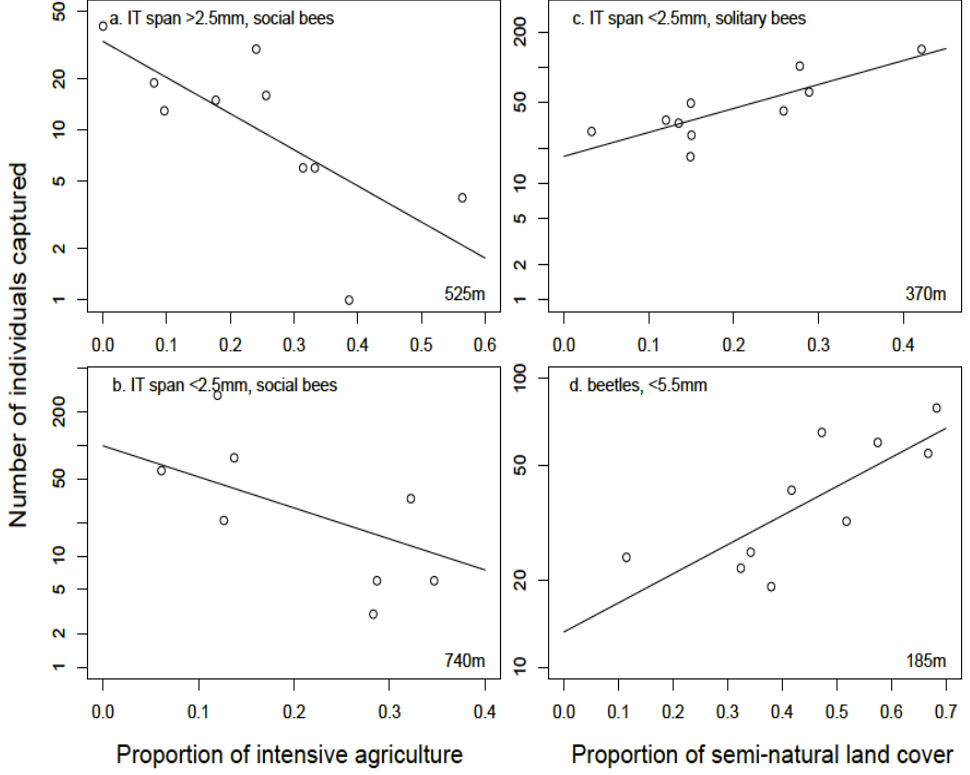
Figure 5. Relationships between functional group abundances of insects and the proportion of intensive agriculture and semi-natural land cover in the landscape surrounding 10 conservation grasslands ( a ) large, social bees with intertegular (IT) span > 2.5 mm ( b ) small, social bees with IT span < 2.5 mm ( c ) small, solitary bees with IT span <2.5 mm ( d ) small beetles with body size < 5.5 mm in length.